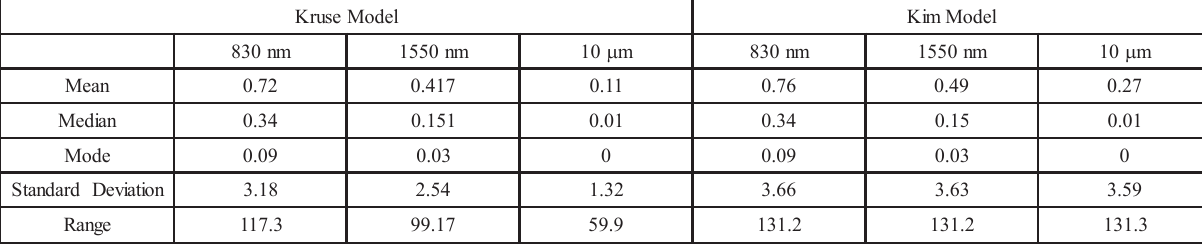
TABLE 3. DESCRIPTIVE STATISTICS OF ESTIMATED OPTICAL ATTENUATION FOR THE YEAR 2010